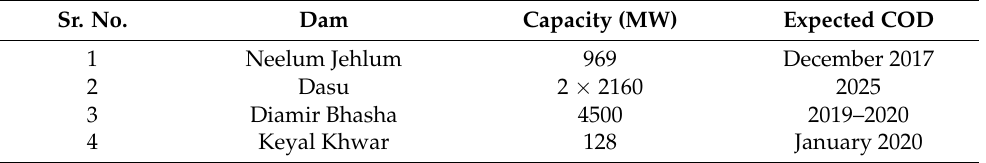
Table 4. Hydropower projects under development in Pakistan. COD: commercial operation dates. Sr.